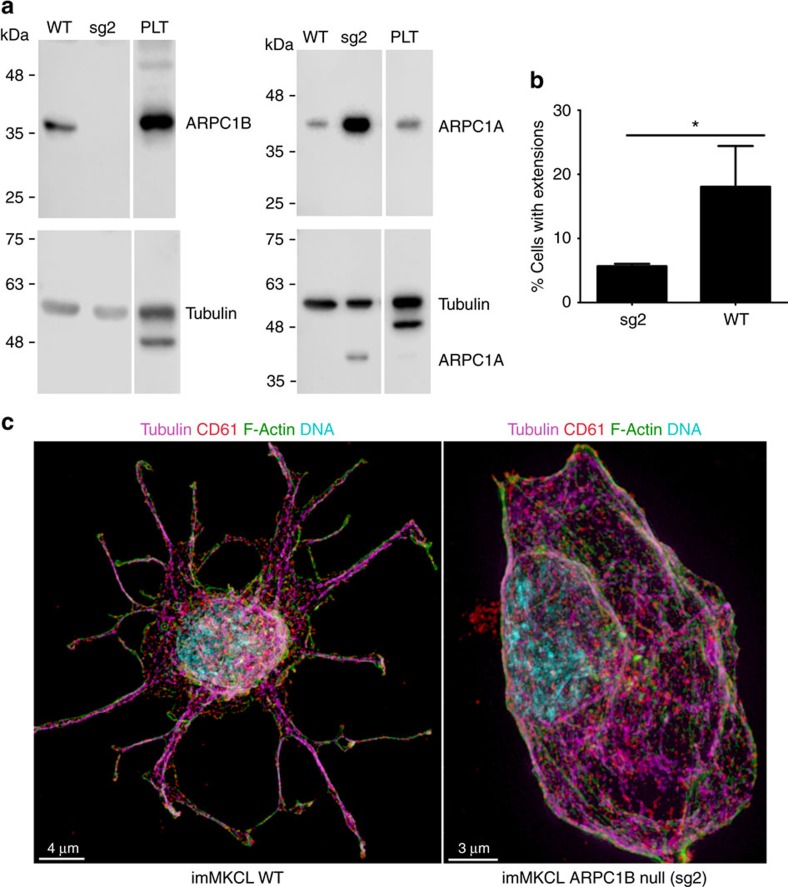
Decreased proplatelet formation in ARPC1B-null megakaryocytic cells.(a) Cell lysate immunoblot analysis showing absent ARPC1B and increased ARPC1A expression in the ARPC1B-null imMKCL megakaryocytic cell line (sg2) relative to wild-type (WT) imMKCL cells and normal platelets (PLT; tubulin loading control for ARPC1B and ARPC1A indicated). (b) Wild-type and ARPC1B-null imMKCL cells were stimulated to differentiate in culture, and CD61-positive cells were scored for the presence of proplatelet-like extensions after 5 days; ARPC1B-null (sg2) cells showed a significantly decreased frequency of proplatelet formation compared to WT (*P<0.05, two-tailed t-test; three experiments with 100 cells per group scored; bars show s.d.). (c) Comparisons of mature cultured representative wild-type imMKCL (left) and ARPC1B-null (right) cells; cells were stained and imaged by laser fluorescence structured illumination microscopy. Only cells expressing ARPC1B were observed to develop multiple structures resembling megakaryocyte proplatelets, containing tubulin and long, thin branched actin fibres (3D renders of images; bars=4 μm left, 3 μm right).